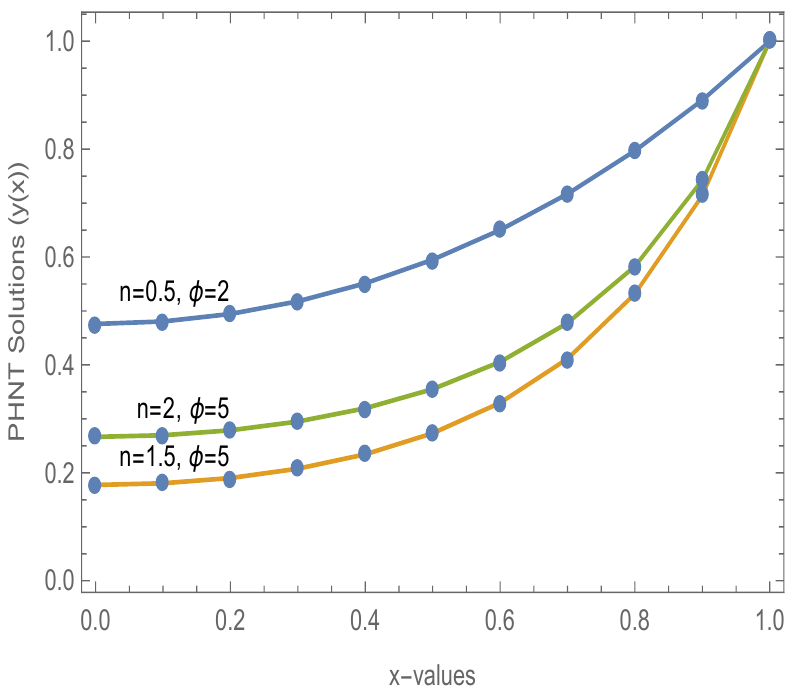
Figure 1. Approximate solutions of PHNT for h = 1